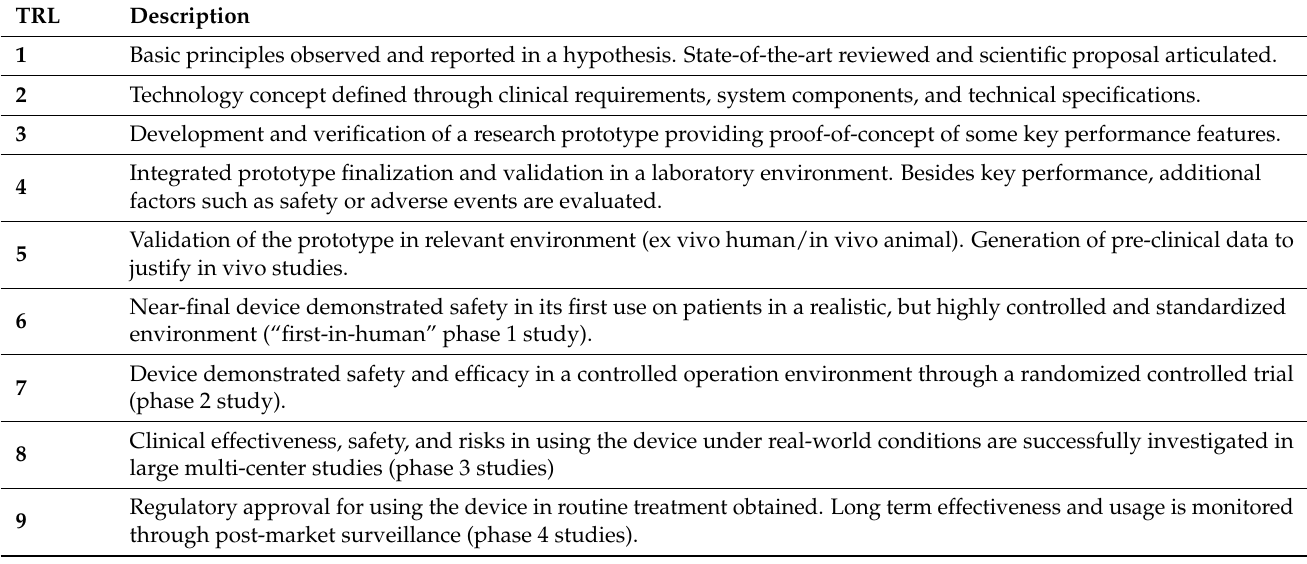
Table 1. The proposed technology readiness level (TRL) scale for medical AR products was obtained by adapting the original NASA (https://www.nasa.gov/directorates/heo/scan/engineering/techn ology/technology_readiness_level, accessed on 7 September 2022) TRL